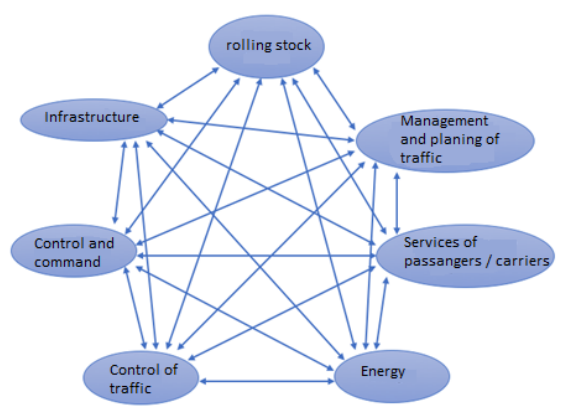
Figure 1. Interlinkages partial rail subsystems in